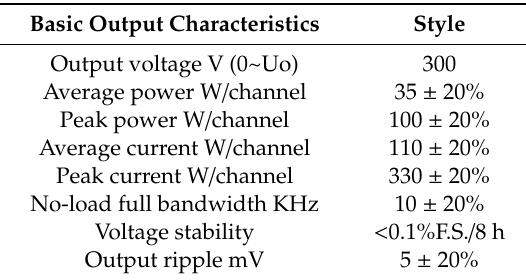
Table 2. The key parameters of